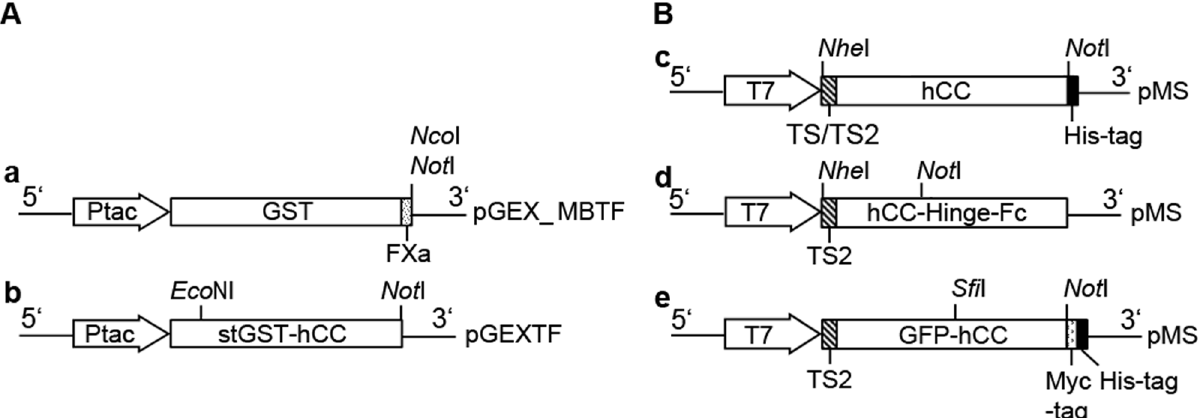
Fig 1. GST and stGST-hCC prokaryotic expression cassettes. Prokaryotic expression cassettes for production of GST ( a ) and stGST-hCC ( a ) in the pGEX5x3-based vector ( pGEX_MBTF , pGEXTF ) and eukaryotic expression cassettes for the production of hCC ( c ), hCC-Hinge-Fc ( d ), and GFP-hCC ( e ) in the pMS-vector ( pMS , Stoecker et al . 2003). Ptac: tac promoter, FXa: Factor Xa cleavage site, GST: Sequence encoding glutathione-S-transferase, stGST- hCC: Sequence coding for the stabilised fusion of GST and human cystatin C (hCC), Nco I, Nhe I, Not I, Sfi I: Restriction sites, T7: T7 promoter/priming site, TS: Native secretion signal of hCC, TS2: Secretion signal from the V-J2-C region of the mouse Ig κ , His-tag: Sequence encoding six histidine residues, Myc- tag: Sequence encoding c-Myc, hCC: Codon-optimised sequence encoding the human cystatin C, hCC-Hinge-Fc: Sequence encoding a fusion protein comprising hCC, the hinge region and fragment crystallisable of a human antibody, hCC-SNAP: Sequence encoding a fusion protein comprising hCC and mutant O 6 -alkylguanine-DNA alkyltransferase, GFP-hCC: Sequence encoding a fusion protein comprising enhanced green fluorescent protein and hCC.